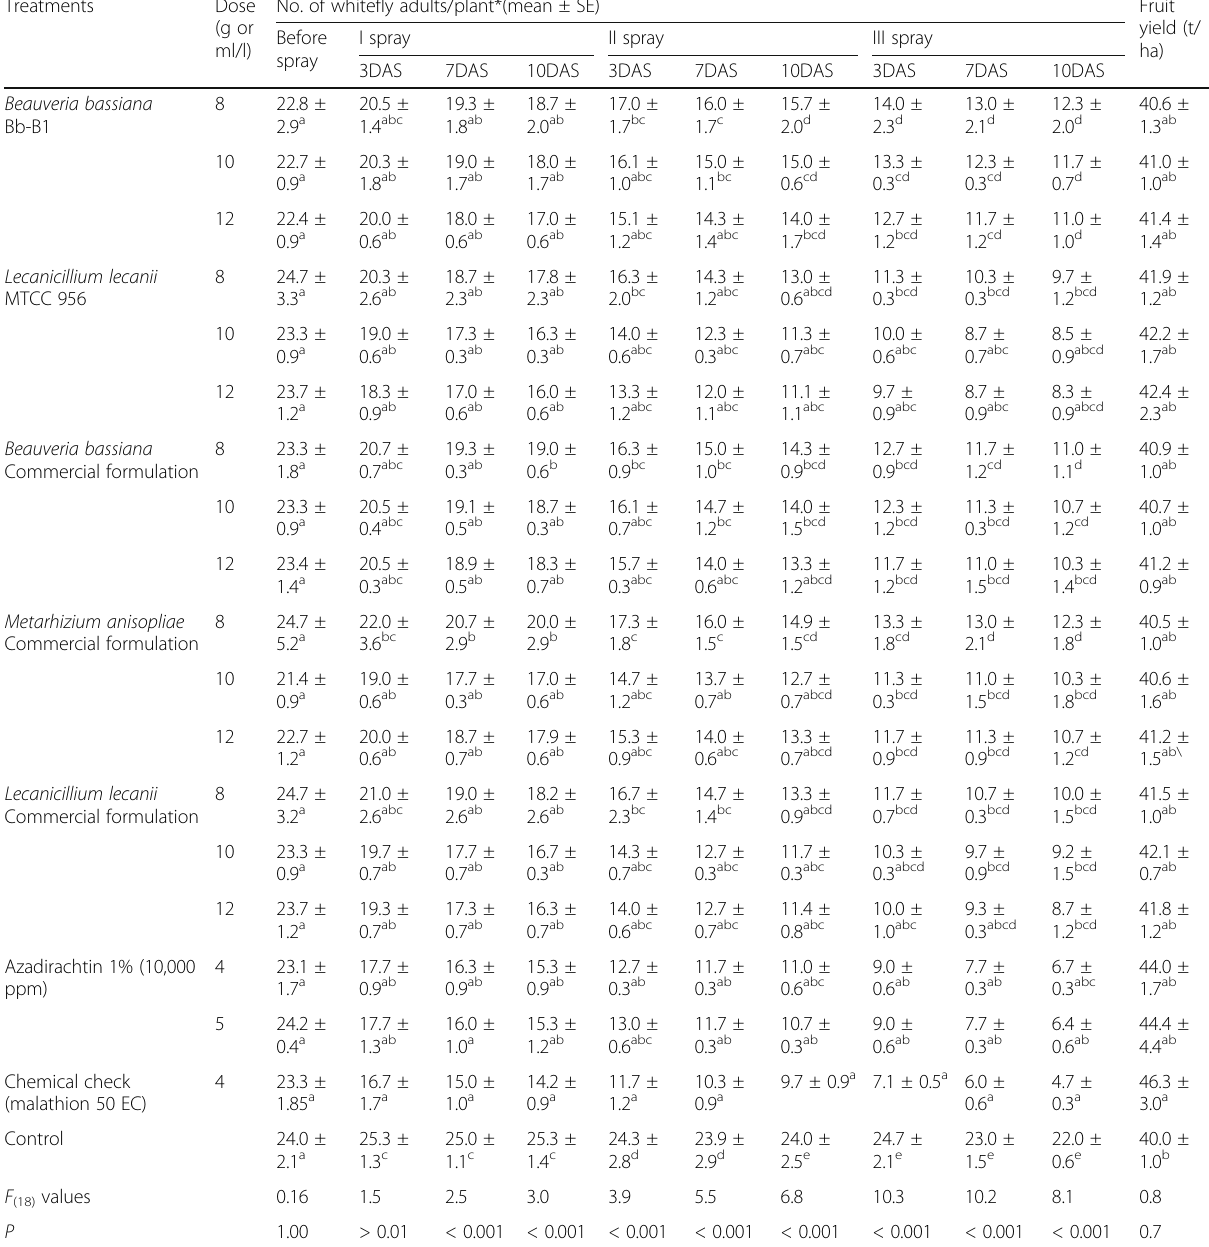
Table 3 Population dynamics of whitefly, Bemisia tabaci (Gennadius) on capsicum plant treated with indigenous and commercial bioformulations under protected cultivation (2017, 2018) Treatments Dose No. of whitefly adults/plant*(mean ± SE) Fruit (g or ml/l)